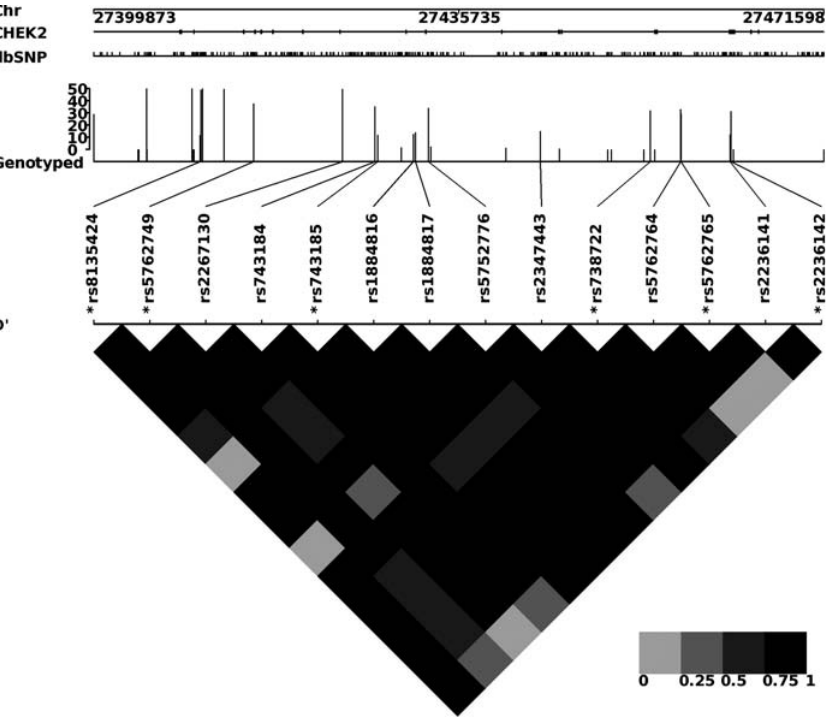
Figure 1. Exon, SNP, and LD Information for CHEK2 Lane 1 (Chr): Physical position on chromosome 22. Lane 2 (CHEK2): Exon locations. Lane 3 (dbSNP): SNPs downloaded from dbSNP build 124. Lane 4 (Genotyped): SNPs genotyped in our study and their respective frequencies in 92 controls. Accession numbers are given for the 14 common SNPs (MAF (cid:1) 0.03) that were in HWE, tagSNPs are marked with asterisks. LD grid: pairwise D 9 between the 14 common SNPs. DOI: 10.1371/journal.pmed.0030168.g001